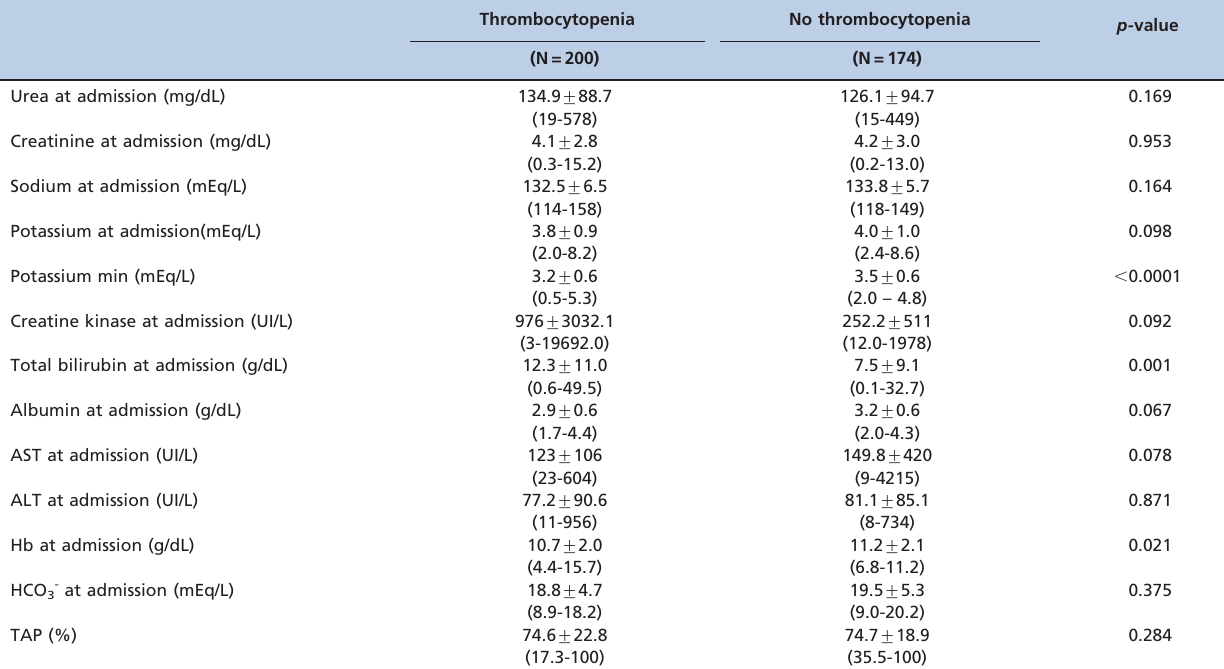
Table 2 - Comparison of laboratory data between leptospirosis patients with and without thrombocytopenia at admission.